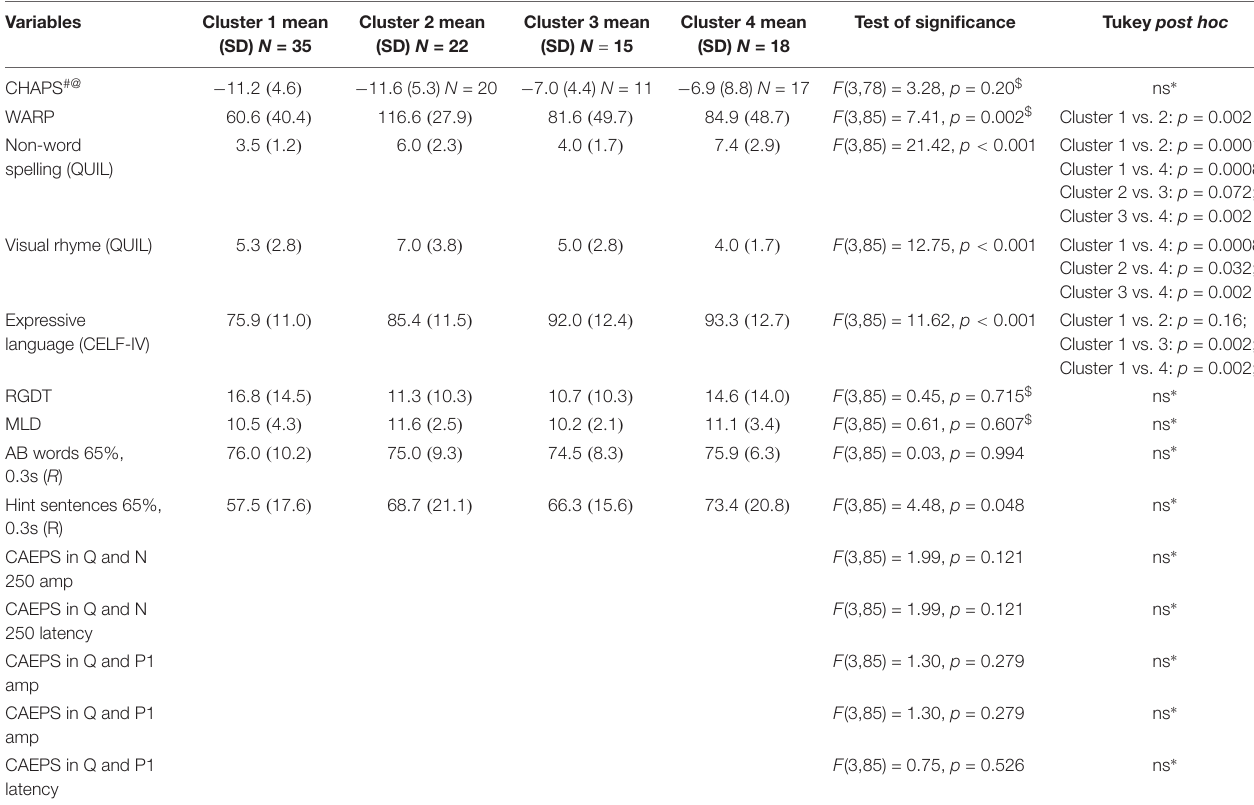
TABLE 5 | Clusters in predicting reading, auditory processing performance, only significant results on ANOVA are shown.